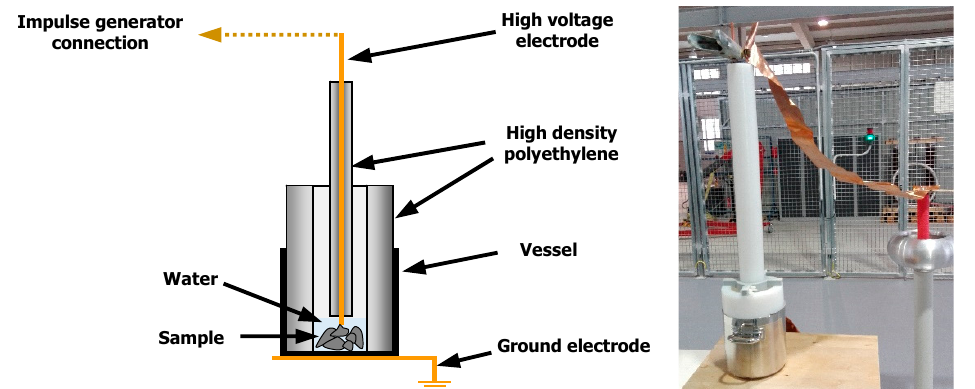
Figure 8. ( Left ): Test cell diagram. ( Right ): Test cell connected to the impulse generator.